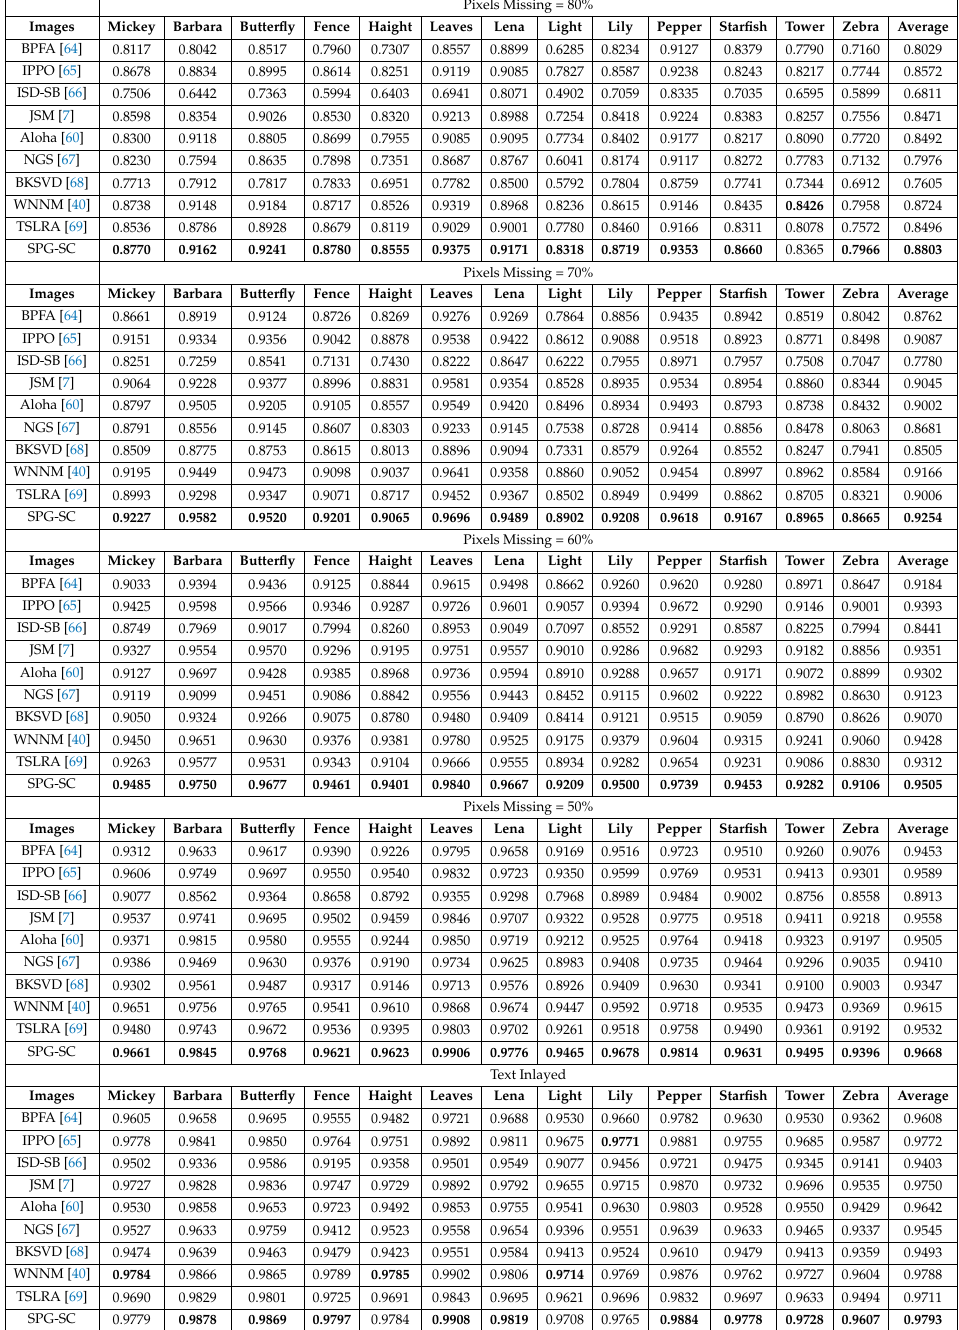
Table 2. SSIM comparison of BPFA [64], IPPO [65], ISD-SB [66], JSM [7], Aloha [60], NGS